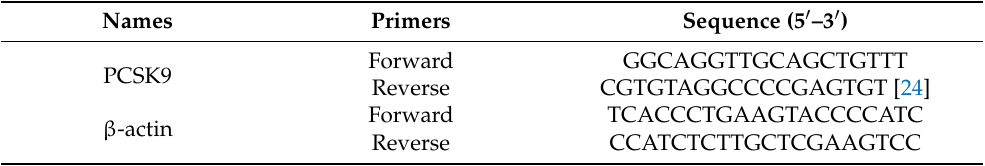
Table 1. Primer sequences used to determine expression of